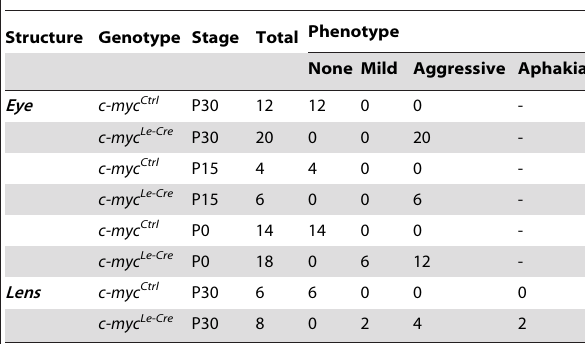
Table 1. Eye phenotypes observed for control ( c-myc Ctrl ) and c-myc-deficient lens ( c-myc Le-Cre ).